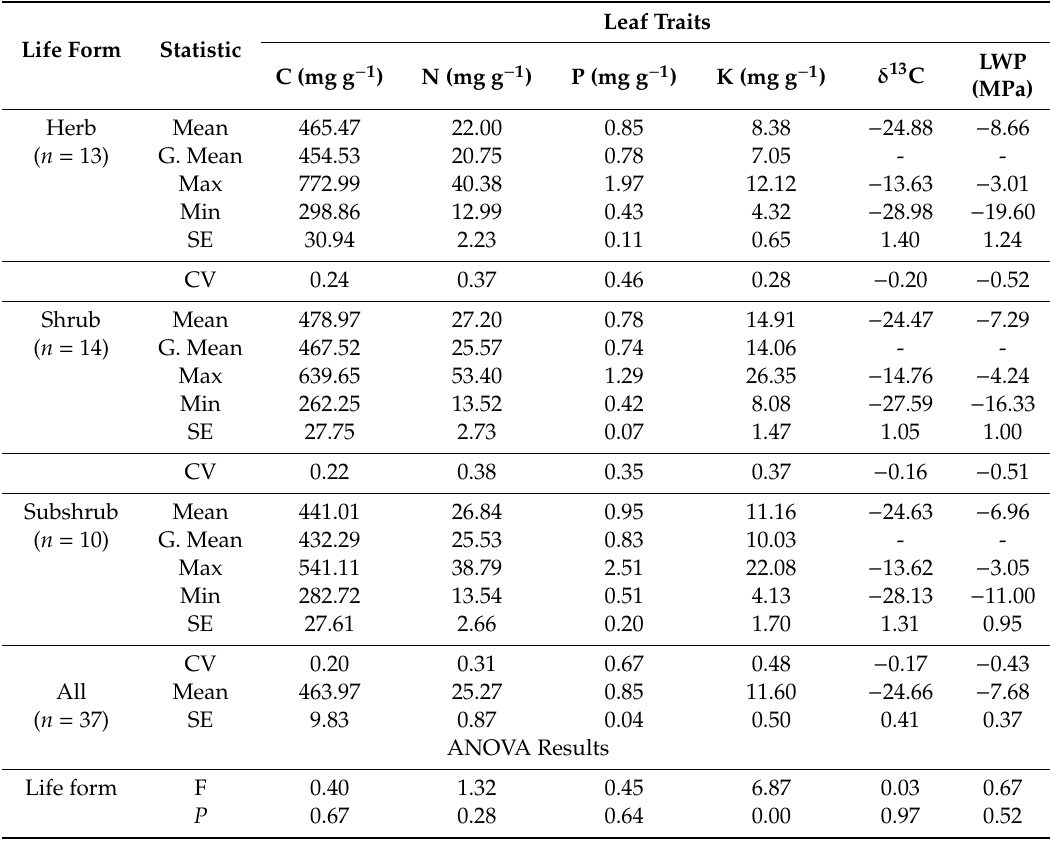
Table 2. Concentrations of analyzed leaf traits: as leaf carbon (C) concentration, leaf nitrogen (N) concentration, leaf phosphorus (P) concentration, leaf potassium (K) concentration, carbon isotope C 13 ( δ 13 C) concentration and water potential ( ψ w ) for plants three di ff erent life forms (such as herb, shrub, subshrub).